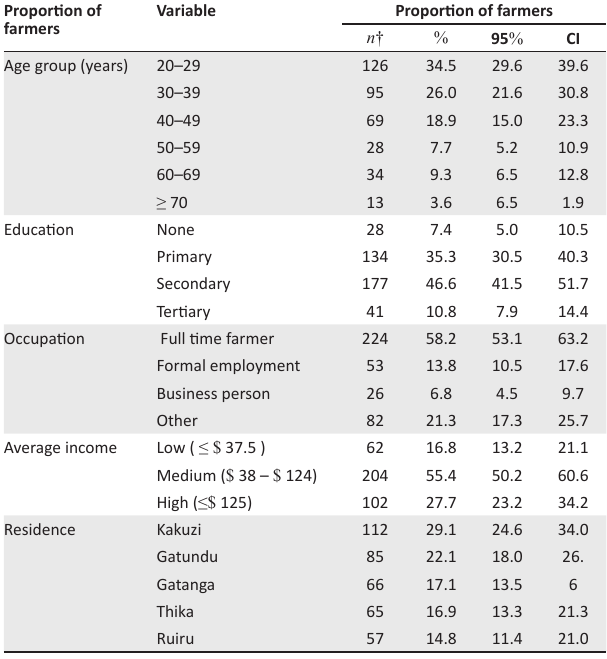
TABLE 1: Socio-demographic characteristics of respondents.